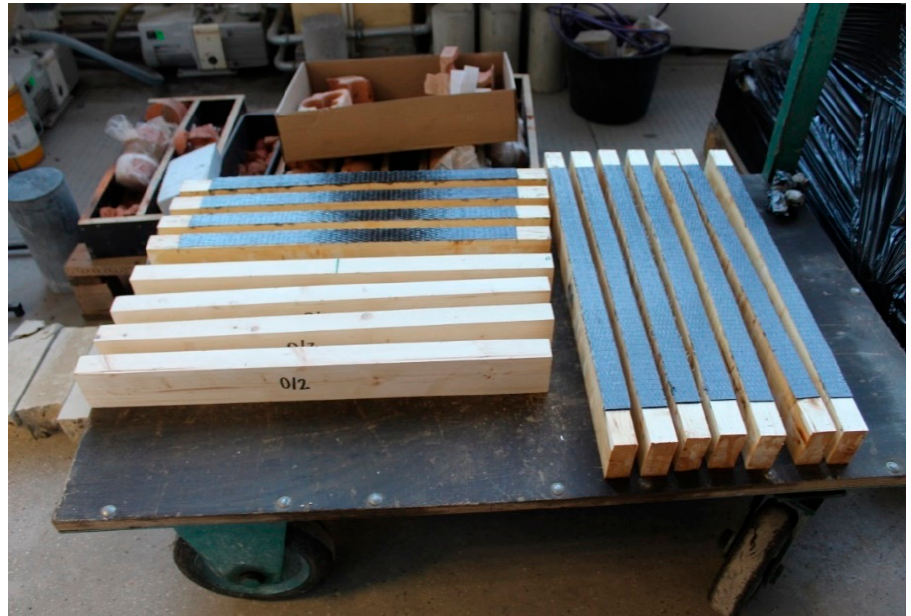
Figure 2. Beams prepared for destructive testing: unreinforced beams and beams reinforced using CFRP Glued Laminated Timber.